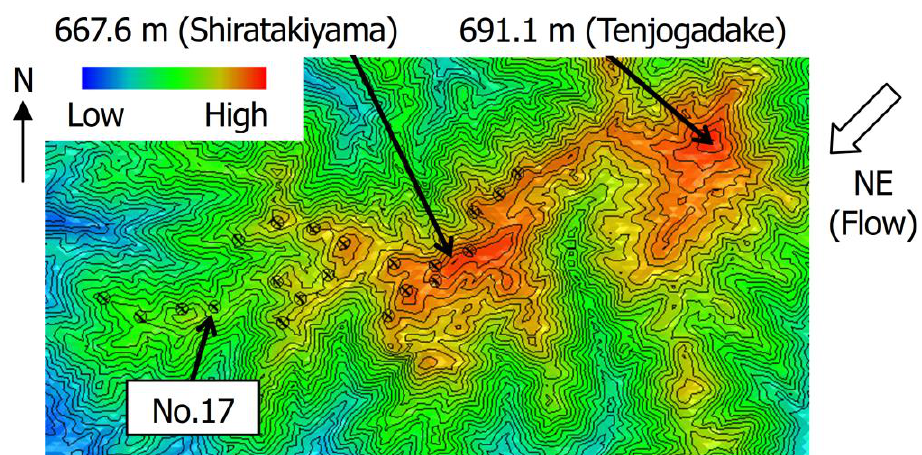
Figure 8. Comparison between 10.0 m resolution terrain elevation data (contour line) and 50.0 m resolution terrain elevation data (shading).